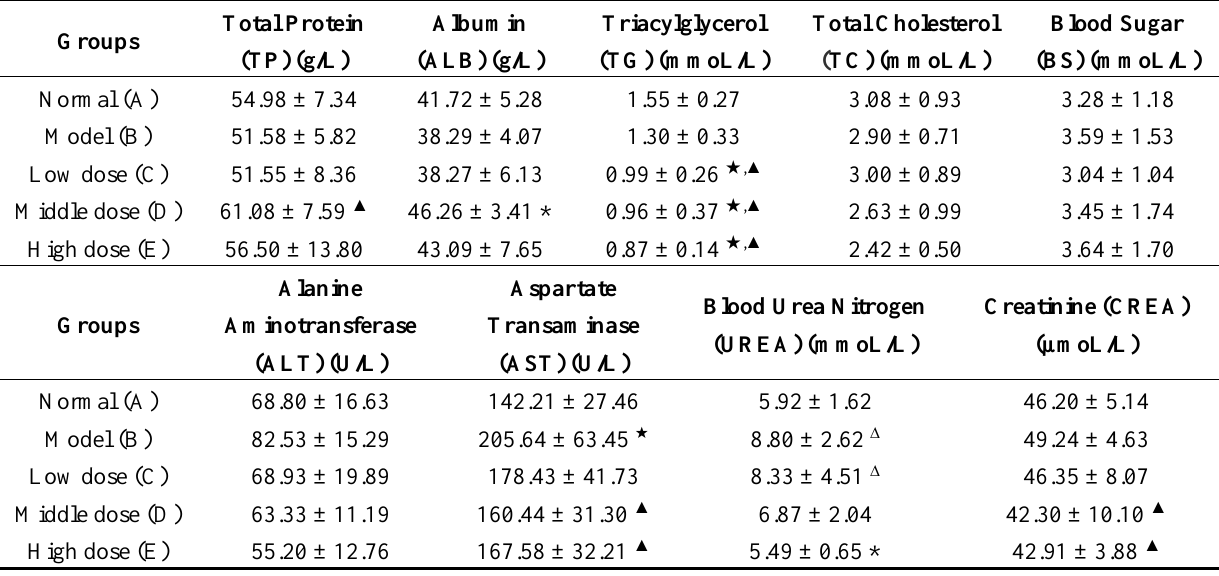
Table 4. Results of blood biochemical tests of mice from each of the five groups ( n = 10, x ± s).